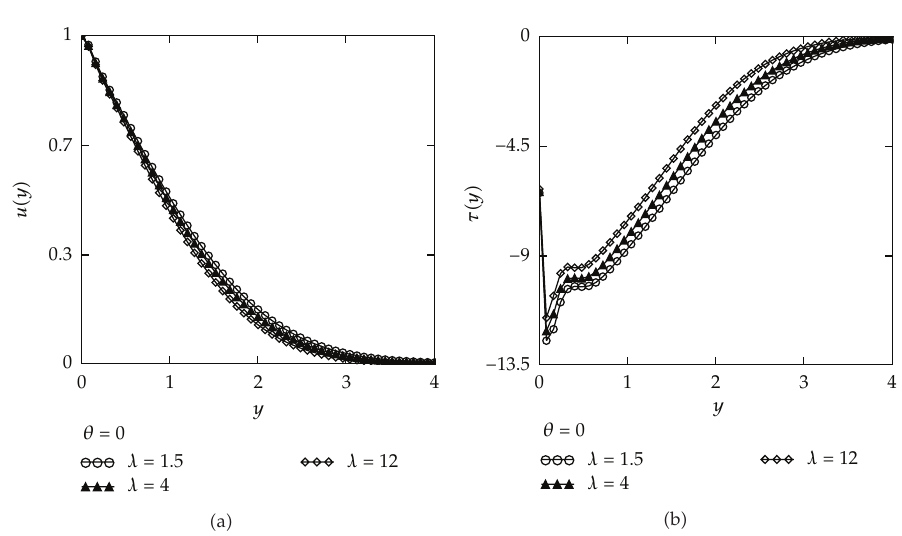
Figure 6: Profiles of the velocity field u (cid:4) y,t (cid:5) and the shear stress τ (cid:4) y,t (cid:5) for fractional Maxwell fluid given by (cid:4) 5.3 (cid:5) and (cid:4) 5.4 (cid:5) , for U (cid:9) 1, y (cid:9) 1, ν (cid:9) 0 . 379, μ (cid:9) 33, α (cid:9) 0 . 2, θ (cid:9) 0 . 0, t (cid:9) 5s, and di ff erent values of λ .